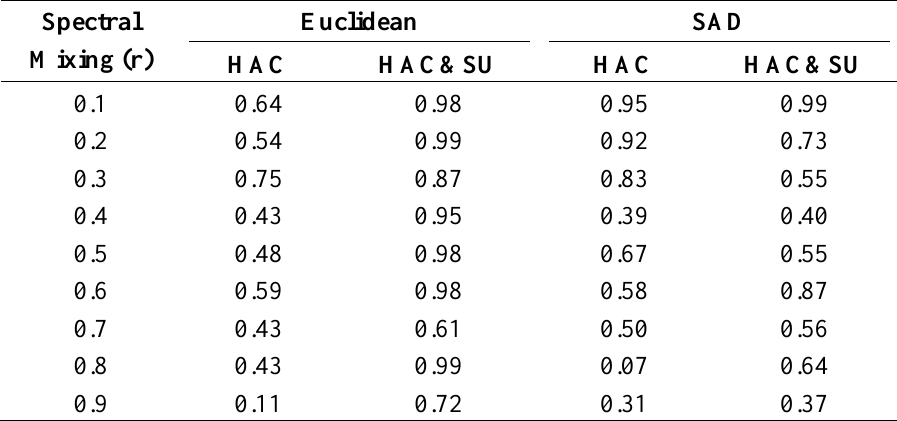
Table 1. Entropy correlation using p = 5 endmembers and increasing fraction r of data with spectral mixing.